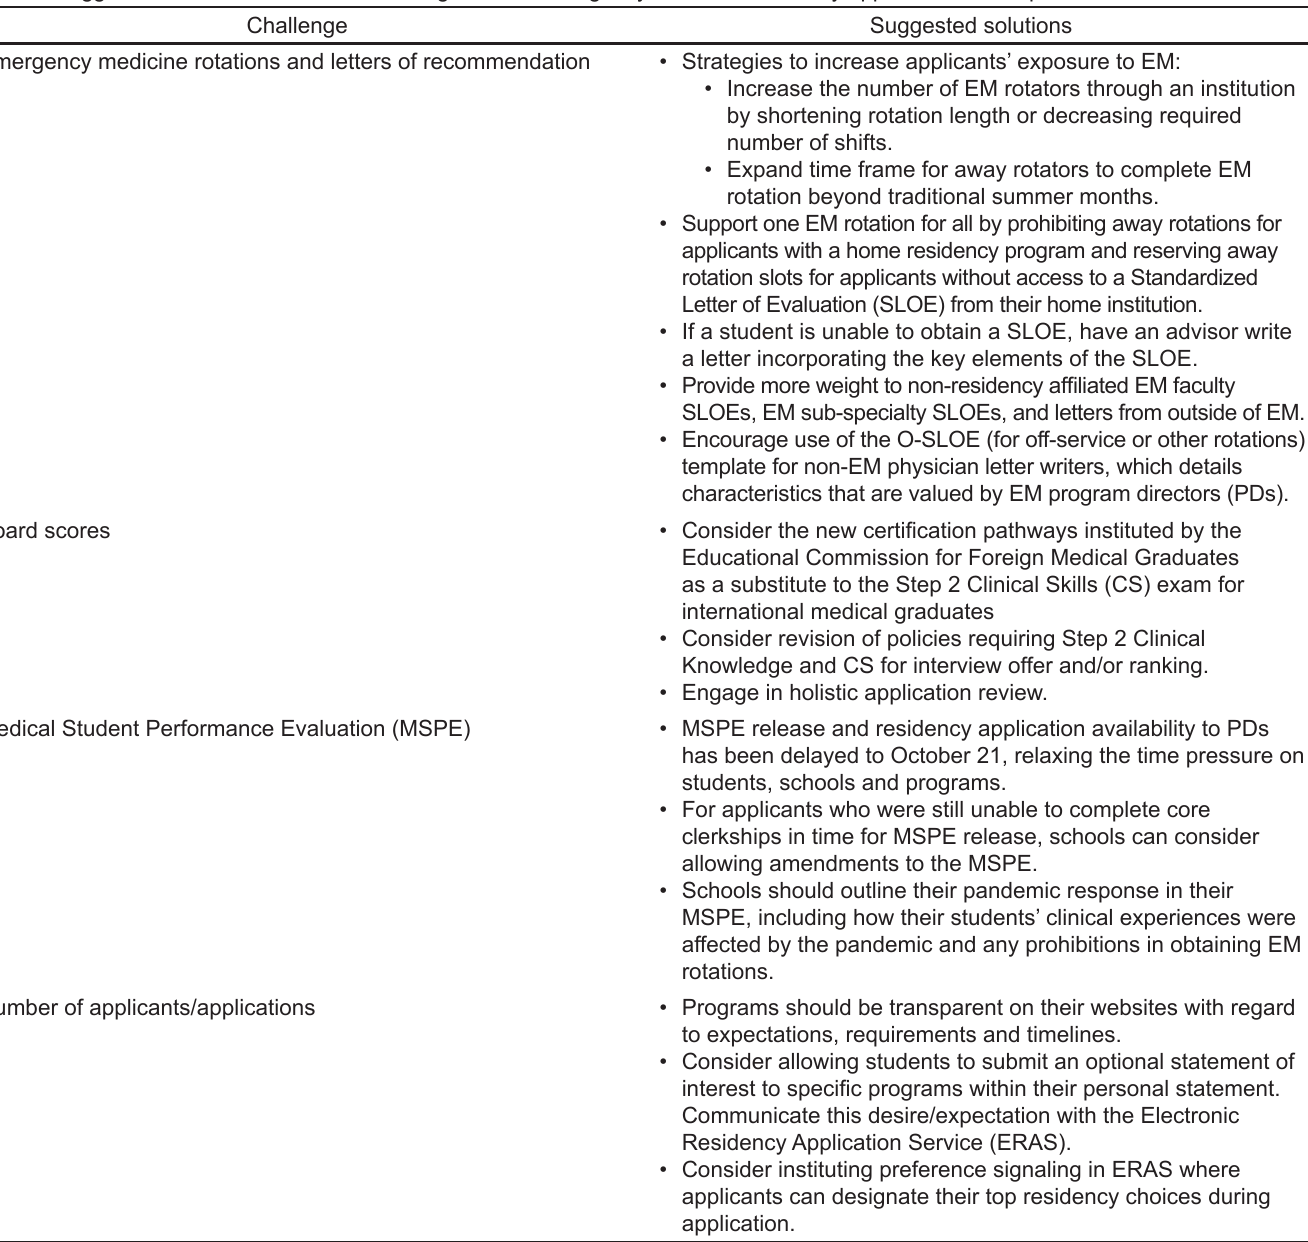
Table 1. Suggested solutions to address challenges in the emergency medicine residency application review process amidst